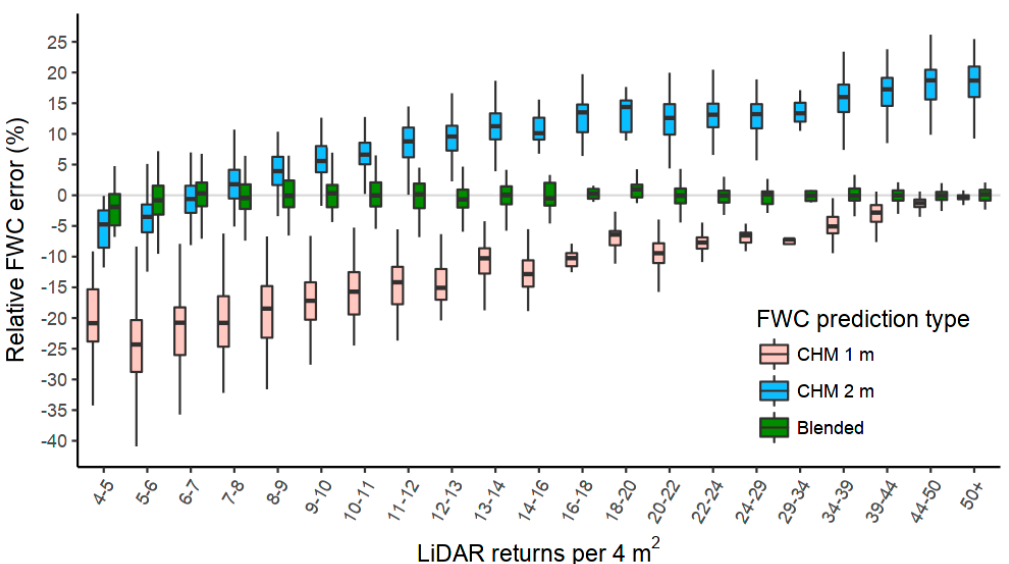
Figure 4. Percentage error of fractional woody cover calculated using 1 m canopy height model (CHM), 2 m CHM and blended model, in relation to LiDAR return density per 4 m 2 . (Note: 4 m 2 was used as the area unit to better illustrate the effect of minor increases in the number of LiDAR